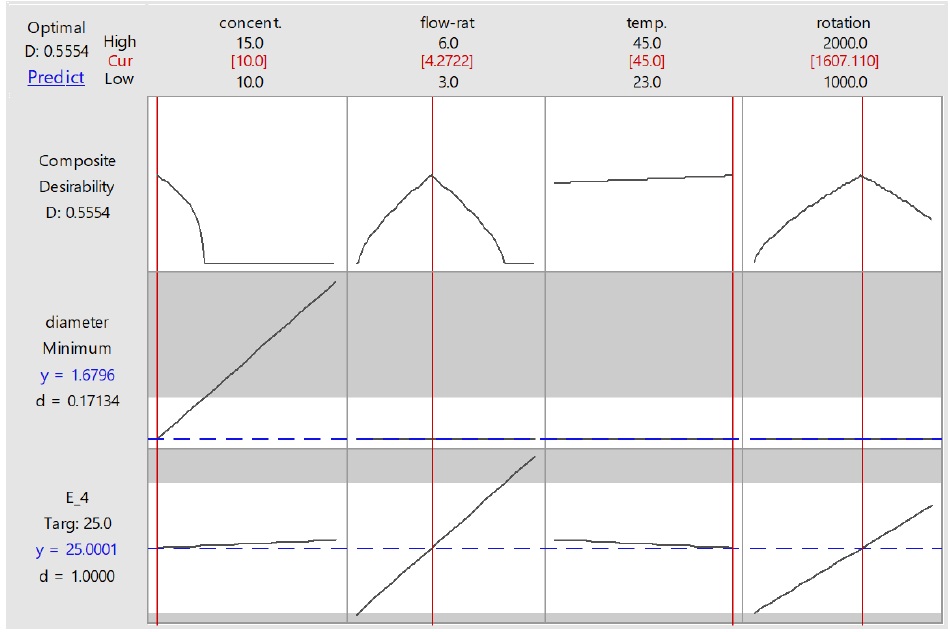
Figure 7. Optimization plot provided by response optimizer. Table 5. Results of confirmation tests.